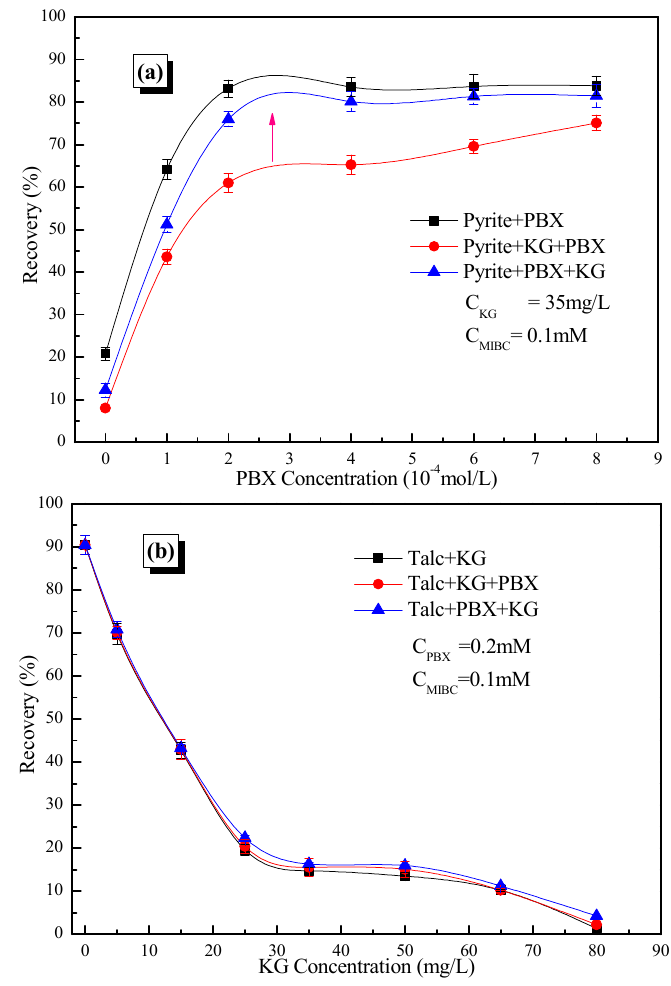
Figure 6. Effect of the KG/potassium butyl xanthate (PBX) addition order on the microflotation recovery of pyrite ( a ) and talc ( b ).